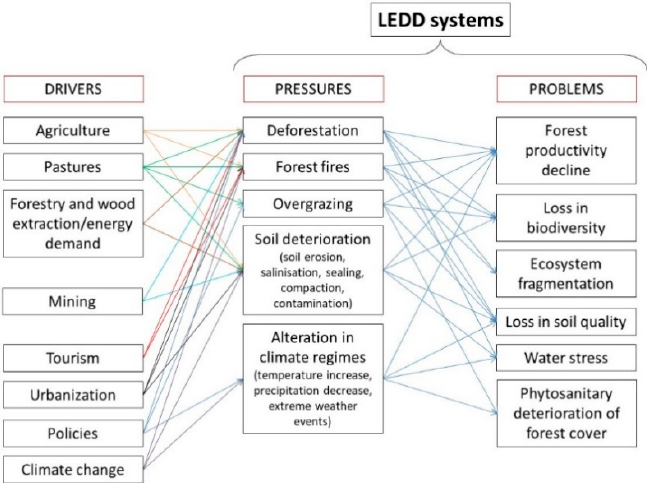
Figure 1. A common framework that illustrates the intrinsic complexity of local systems exposed to “soil, Land and Ecosystem Degradation and Desertification risk” (LEDD).